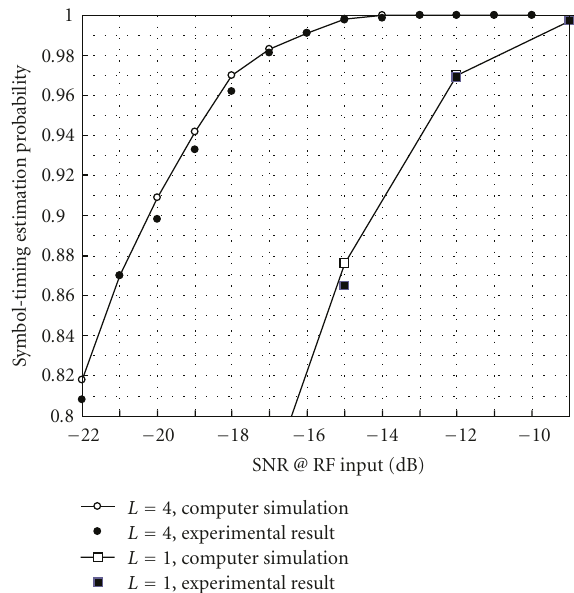
Figure 11: Experimental results of the proposed ranging